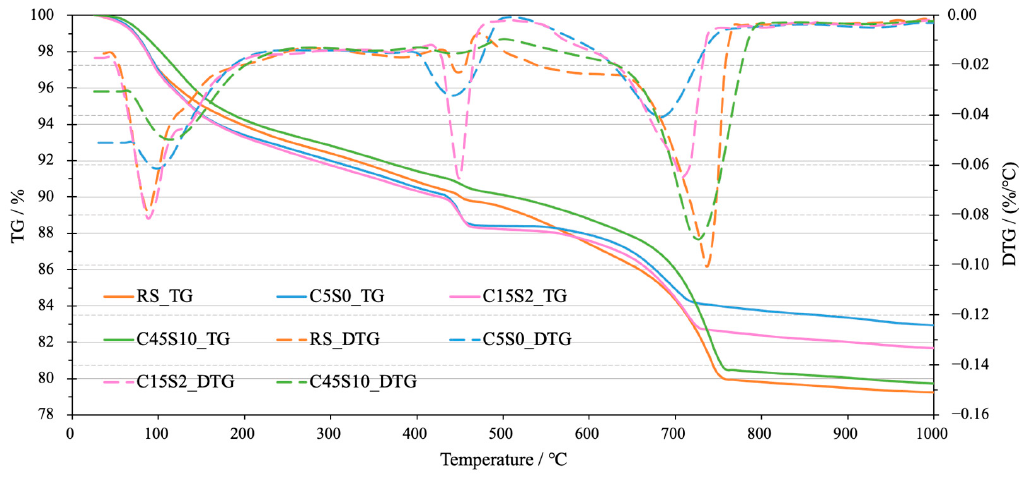
Figure 12. Results from the thermogravimetric analysis.